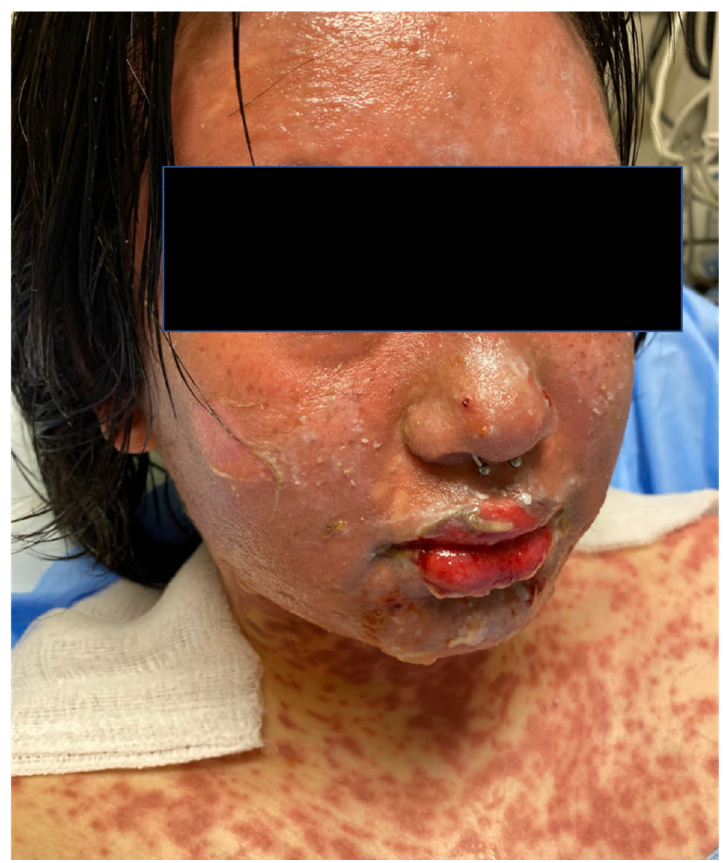
Figure 1. A patient with toxic epidermal necrolysis due to carbamazepine. Dusky macules which reach confluence, along with epithelial detachment on the face and lips.